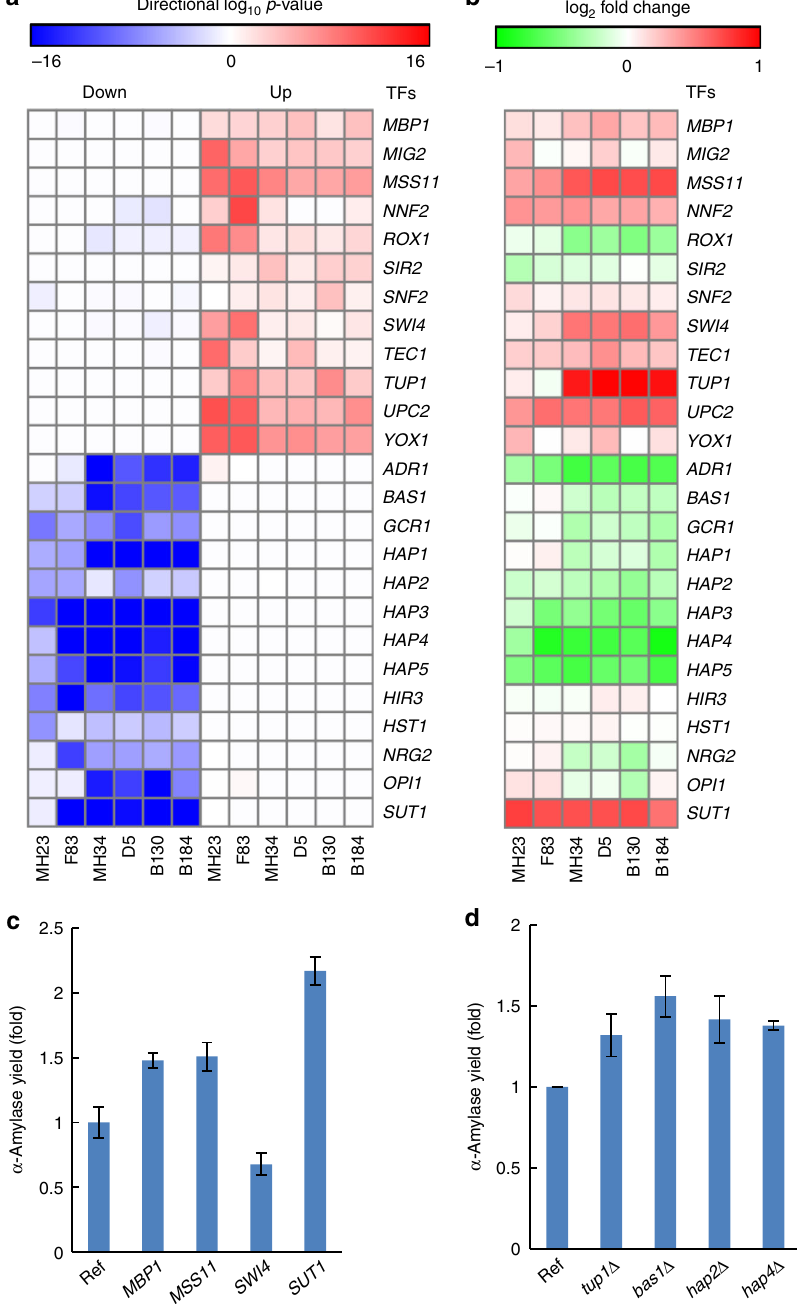
Fig. 3 Reporter transcription factors (TFs) analysis revealed important transcriptional network responses in mutant strains. TFs were scored by the modulation in expression level of genes that controlled by TFs. a The top fi ve scored reporter TFs for each strain in distinct-directional up class (red) and distinct-directional down class (blue) are chosen and presented by their signi fi cance. b Expression levels of reported TFs in the mutant strains compared with the reference strain AAC. Enhanced production of α -amylase by overexpression of TFs c or deletion of TFs d , data shown are mean values ± standard deviations of